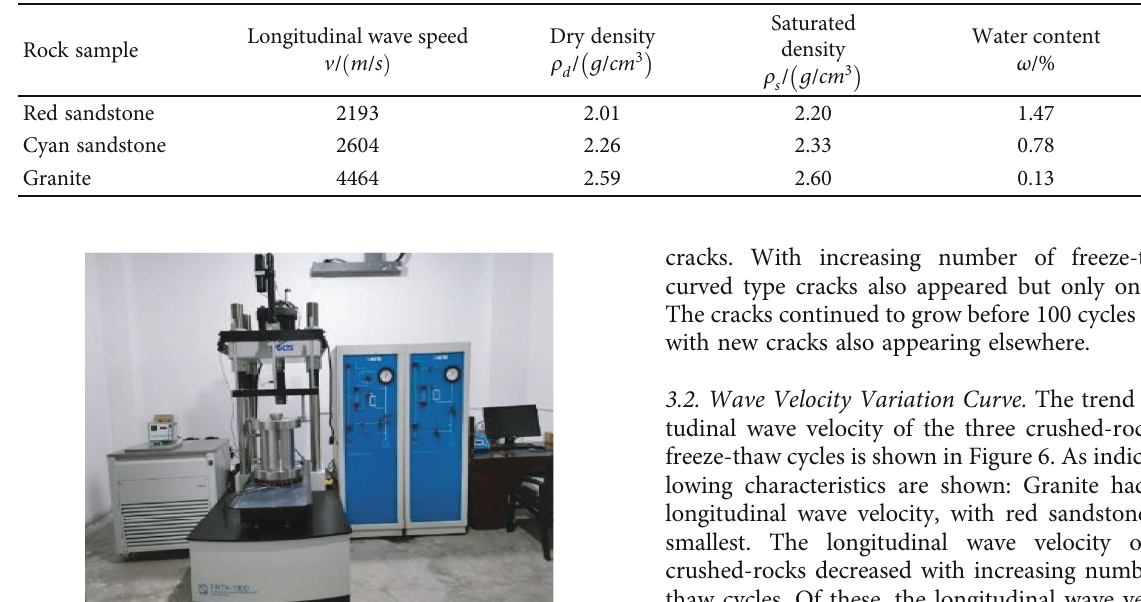
Table 1: Basic physical parameters of the rocks.